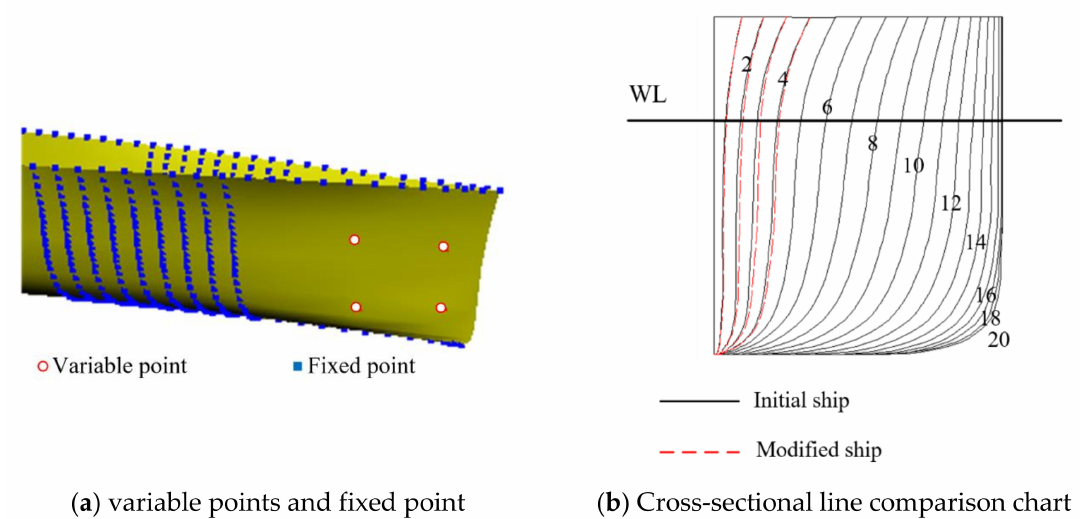
Figure 9. Bow modification with constrained